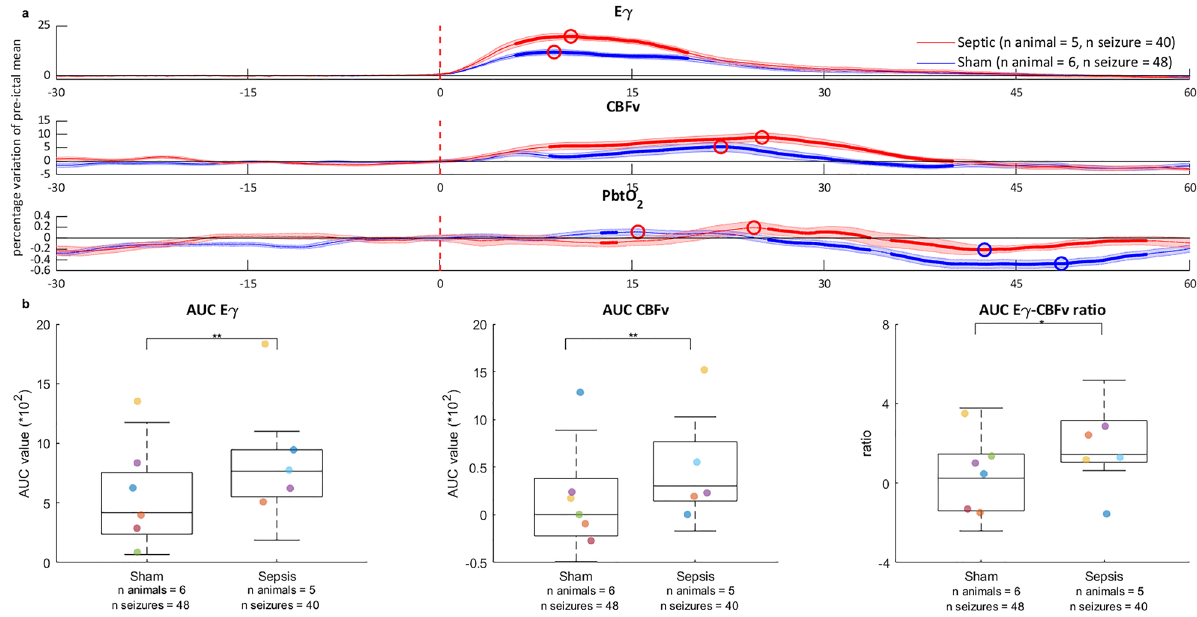
Figure 1. Local effects of seizures in the sham and sepsis groups (panel a ) and comparison between groups of the area under the curve of the Eγ and of the CBFv variations and their ratio (panel b ). Eγ: EEG gamma power envelope, CBFv: cerebral blood flow velocity, PbtO 2 : partial tissue oxygen pressure, AUC: area under the curve, *P < 0.01, **P < 0.001. Panel ( a ): in blue, mean ± SD seizure-induced value variation in time in sham group; in red, mean ± SD seizure-induced value variation in time in sepsis group. Mean and SD are calculated using bootstrapping with replacement and 100 iterations. Circles correspond to the peaks of a parameter variation (red circles for the positive and blue for the negative ones). Time 0 corresponds to the seizure onset (vertical dashed red line); curves were centered to zero at seizure onset. Differences between groups, identified by Wilcoxon Mann-Whitney rank sum test, are bolded and calculated on the raw data without bootstrapping. The increase in both CBFv and PbtO 2 is delayed in the sepsis group (see text for “Discussion” section). Parameters are expressed in percentage of variation from the mean of the last 15 pre-ictal seconds except for Eγ, where baseline values were simply set to zero. Panel ( b ): boxplots of the AUC of the Eγ and of the CBFv variations and their ratio. An increase in the Eγ and the CBFv AUC was noted in the sepsis group (P < 0.001 for ture, pH, PaO 2 or PaCO 2 . Before correction for false discovery rate, pH was lower in the septic shock group than in the two others ( P = 0.043 with sham and P = 0.07 with the septic group). The fast/delta ratio calculated before penicillin application was statistically lower in the septic shock group than the sham and sepsis groups, but did not differ between the sham and sepsis groups (Table 1). We observed no difference in the latency to the first seizure nor in the total number of seizures per animal between the sham and early sepsis groups ( P = 0.88 and P = 0.83 respectively). Although the total dose of applied penicillin did not differ between groups, we were not able to induce seizures in the septic shock group. Of note, the total observation time was shorter, albeit non-significantly, in the septic shock group, since spontaneous death occurred. On the other hand, there were no differences between the total observed period in the septic shock group and the latency to the first seizure in other animals ( P = 0.57). Cerebral parameters variations during seizures. Figure 1, panel a shows the ictal variations of local and systemic parameters. In the sepsis group, the increase in the Eγ was greater throughout all the duration of the seizures than in the sham group. On the other hand, the ictal increase in the cerebrovascular parameters did not differ between the two groups, albeit the CBFv variation lasted longer in the septic animals. In the sepsis group, the AUC of ictal variations of both Eγ and CBFv was greater than in the sham group (P < 0.01, for both, Fig. 1, panel b). The variations in Eγ and CBFv were positively correlated in both groups (Spearman’s coefficient ρ = 0.4, P = 0.02 for shams & ρ = 0.44, P = 0.02 for sepsis, Supplementary material, Table S1). The Eγ /CBFv ratio was greater in the sepsis group ( P = 0.002, Fig. 1, panel b). The positive ictal variation of the PbtO 2 did not differ between groups ( P = 0.66) but the post-ictal decrease in PbtO 2 was both longer and deeper in the sham than in the sepsis group ( P = 0.02). There were no statistically significant differences in the peak lags between groups (Supplementary material, Table S2). The temporal evolution of synaptic gains is shown in Fig. 2. We considered three meaningful parameters—the average excitatory (Ae), the slow and fast inhibitory synaptic gains (B and G) – which describe the interactions between four modeled populations of neurons (main population of pyramidal cells, excitatory interneurons, slow inhibitory and fast inhibitory interneurons). All the gains decreased during seizures in both groups but, in the sepsis group, a delayed onset of the variation in all the considered parameters was observed. Accordingly, the lag to the peak of the negative variation tended to be delayed, albeit not signifi- cantly ( P = 0.67 for Ae, and P = 0.19 for G, Supplementary material, Table S3). The AUC of the synaptic gains